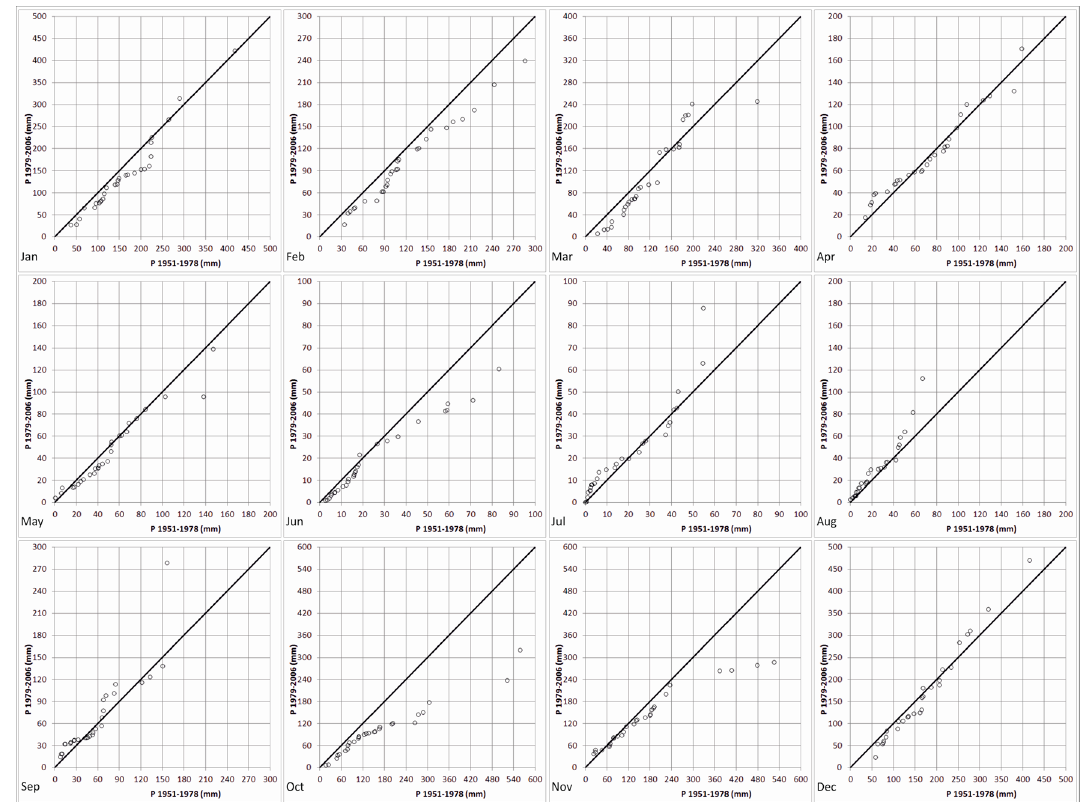
Figure 3. Results of the ITA method for the Rainfall Zone I2 for the period